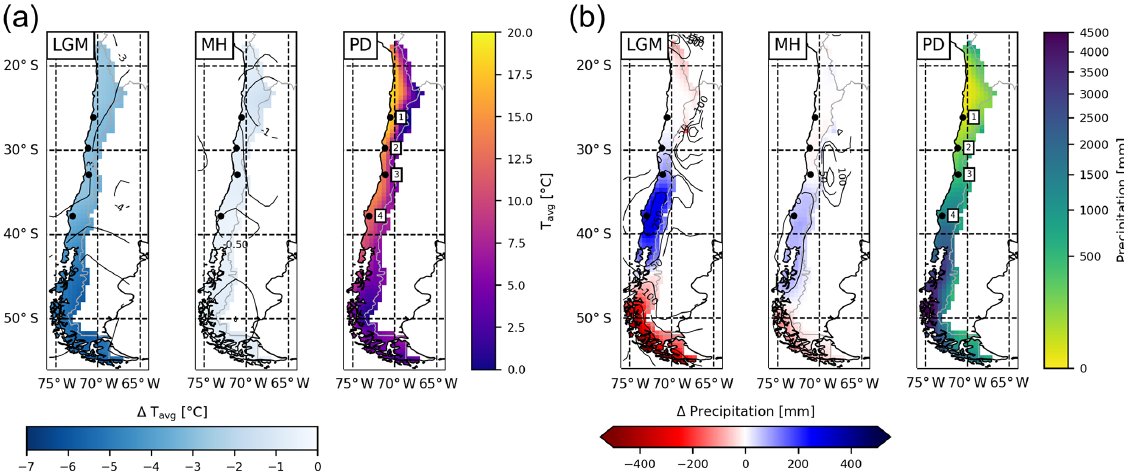
Figure 3. (a) Average annual temperature and (b) precipitation derived from the downscaled and bias-corrected TraCE-21ka transient paleoclimate data (Liu et al., 2009) for the Last Glacial Maximum (LGM), mid-Holocene (MH), and present day (PD) time slices (data is the average of 30 year monthly data; 1 represents Pan de Azúcar, 2 represents Sta. Gracia, 3 represents La Campana, and 4 represents